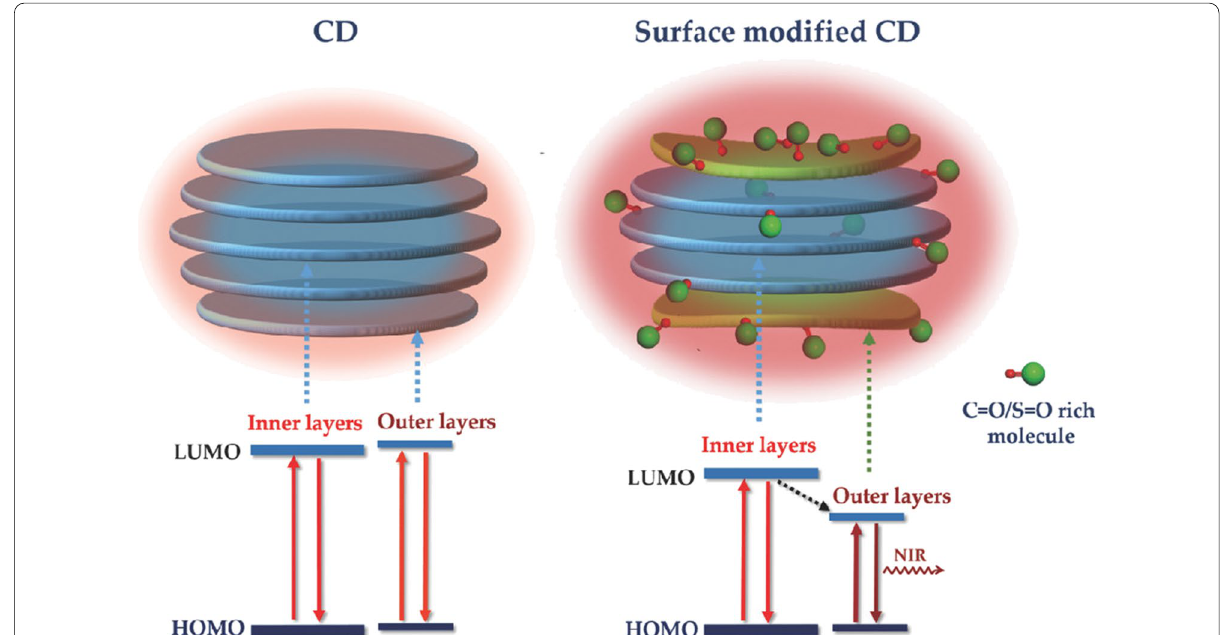
Fig. 4 Schematic of structure and energy level alignments of nontreated CDs (left column) and CDs modified with S (right column). The red (oxygen atom) and green double ‐ bonded balls represent the C